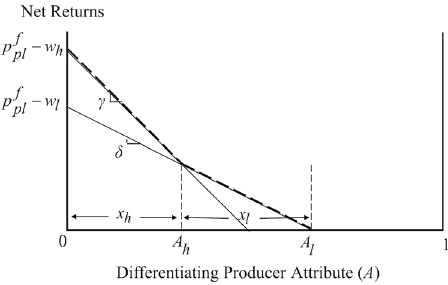
Fig. 7 Impact of undifferentiated low-quality product. This fi gure summarizes the combinations of the common and idiosyncratic costs associated with the production of the low-quality product that lead to the four scenarios considered in